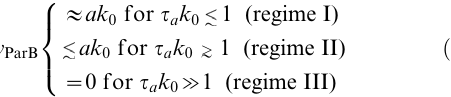
Figure 3. Dependence of translocation velocity on disassembly rate and relaxation time. (A) Translocation velocity, v ParB (solid symbols), increases with depolymerization rate, k d . At low k d , v ParB is linear in k d , scaling as ak d (green curve), where a is the diameter of a ParA subunit. At large k d , with an arbitrarily fast hydrolysis rate, k h , the ParB polymer detaches from the ParA bundle in an observably short time, S t detach T (open symbols). The dashed line separates the regime of translocation from the regime of detachment. For small k h (red triangles), translocation velocity saturates at intermediate values of k d and v ParB . Inset: Ratio of the z -component of the radius of gyration of the ParB polymer squared to the r - = R 2 ). At large k d , the polymer stretches along the axis of motility. The black dotted line marks the k d at which the component squared ( R 2 z r depolymerization time, 1 = k d , exceeds the effective relaxation time, t a (Eq. 2), of the ParB polymer. The green dashed line indicates R 2 which is expected for an isotropic polymer coil. (B) v ParB grows with hydrolysis rate for small k h and saturates at k h & k d (indicated by dotted line). This behavior can be fit by 1 = v ParB ~ 1 =‘ k h z 1 = ak d (green, see Eq. 3). Inset: Variation of the best-fit length scale, ‘ , over ParA subunit diameter, a , with k d . (C) v ParB is insensitive to the total drag, f ParB , on the ParB polymer over several orders of magnitude for both fast k h (black) and slow k h (red). For very large f ParB , the ParB polymer translocates more slowly. (D) For a fixed quantity of ParB as one component of the polymer, longer polymers move more slowly than shorter polymers for both fast k h (black circles) and slow k h (red triangles). Unless noted to be varying, variables have the following values: k d ~ 1230s { 1 , k h ~ ? (black circles) or k h ~ 250s { 1 (red triangles), E ~ 8 k B T , f ParB ~ 300 f 0 ~ 1 : 6 : 10 { 4 g = s , L ~ 500nm , and there are 50 subunits that can bind to ParA in the ParB polymer. In (D), f ParB ~ (5( L = a { 50) z 50) f 0